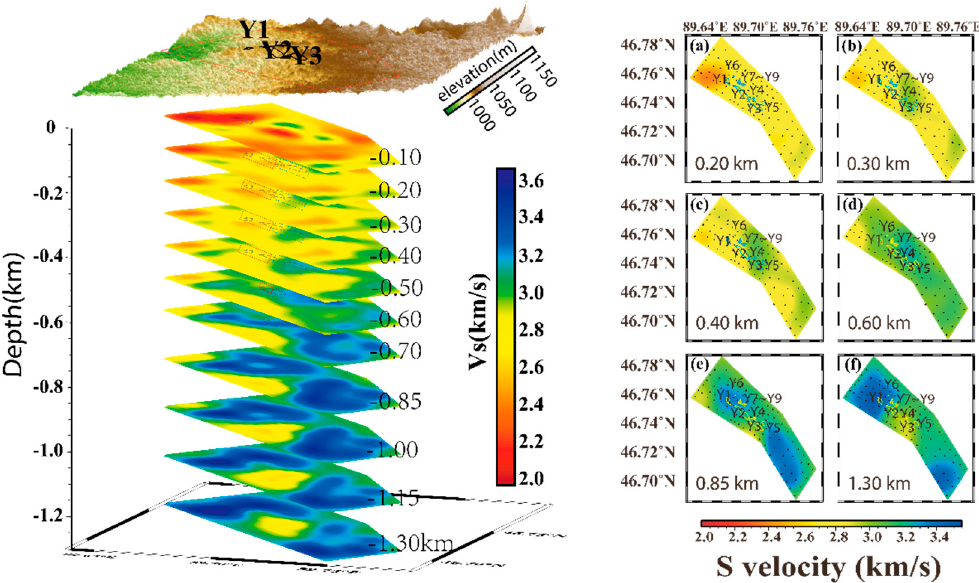
Figure 8. Left panel shows 3D shear wave velocity slices at the depth of 0.1, 0.2, 0.3, 0.4, 0.5, 0.6, 0.7, 0.85, 1.0, 1.15 and 1.30 km, respectively. Black lines at the left top panel of topographic pattern and black dotted lines at 0.1~0.7 km in the lower panel all show ore hosting intrusions. Red solid rectangles represent LVZs at Y1 and northwest of Y2. Blue dotted rectangles indicate HVZs southeast of Y2 and Y3. Right panel represents horizontal slices of shear wave velocity in the mine at the depth of 0.2, 0.3, 0.4, 0.6, 0.85 and 1.3 km (a-f). Areas circled by blue lines on the upper panel and yellow lines on the bottom panel are the ore-hosting intrusions Y1~Y9 in Karatungk mine.